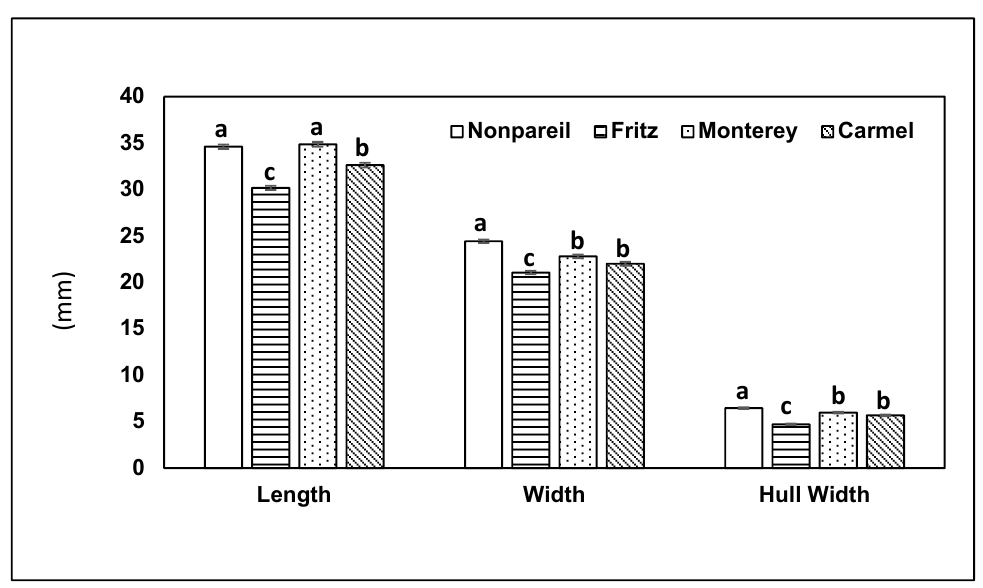
Figure 3. Mean ( ± SE) almond length and width, and hull width, in four almond varieties in 2014. Overall test within each parameter is by Kruskal–Wallis, and pairwise comparisons are by Steel–Dwass tests ( p < 0.05). Within each parameter, columns with the same letters do not differ significantly.